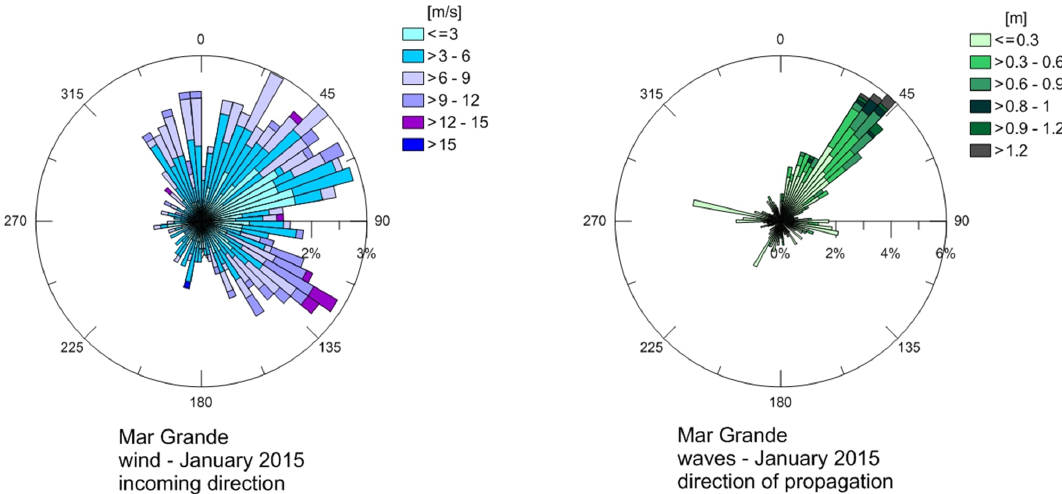
Figure 4. Polar plot of measured wind and waves in January